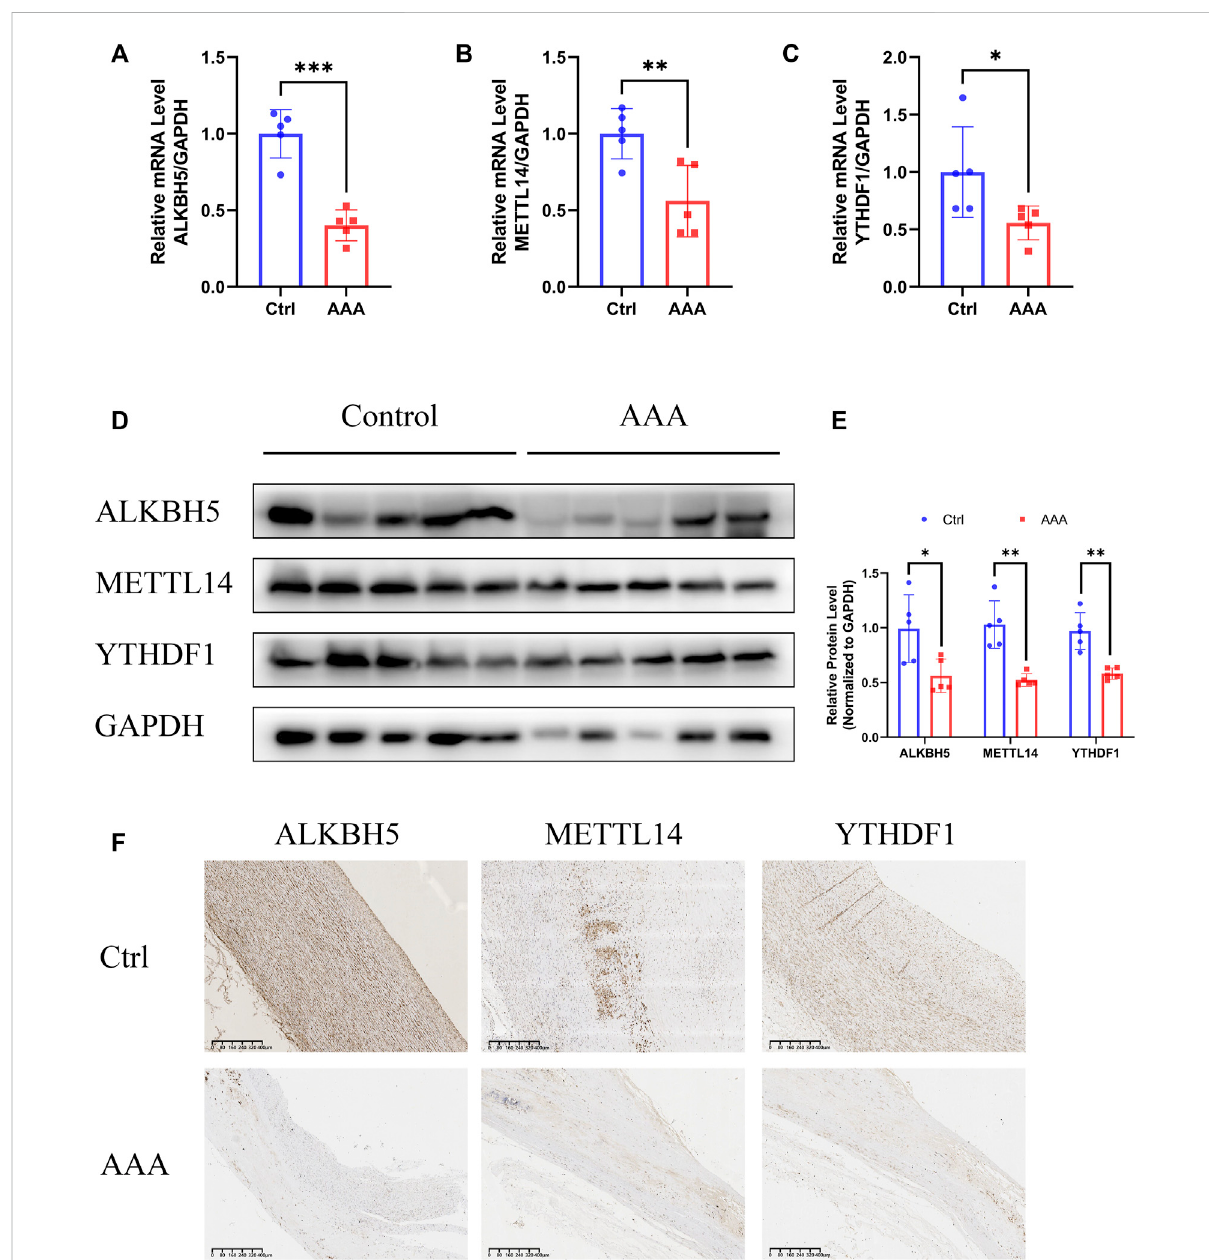
FIGURE 3 Validation of expression of ALKBH5 , METTL14 and YTHDF1 . (A – C) The expression of ALKBH5 , METTL14 and YTHDF1 , detected by qRT-PCR assay. GAPDH servedasthereferencegene.Errorbarsrepresentthemean±SD. (D,E) Theproteinlevelsof ALKBH5 , METTL14 and YTHDF1 ,detected byWestern blotassay. (D) GAPDH servedas theloadingcontrol. Histogramanalysisoffoldchange ofproteinlevels isshown. (E) Errorbarsrepresent the mean ± SD. (F) The expression of ALKBH5 , METTL14 and YTHDF1 in AAAs and normal aortas, detected by IHC. Scale bar, 400 μ m. All experiments are performed in biological triplicate. * p < 0.05, ** p < 0.01, *** p <